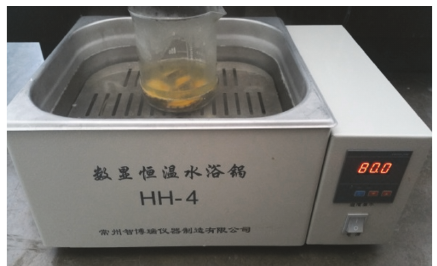
Figure 1: The thermal processing of abalone meat.